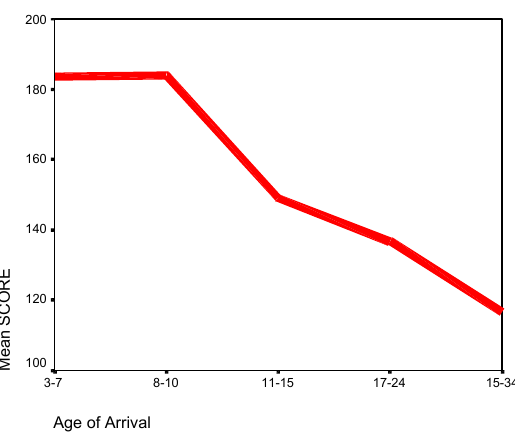
Different AoA Groups and their Mean Scores on the GJT (N=34)